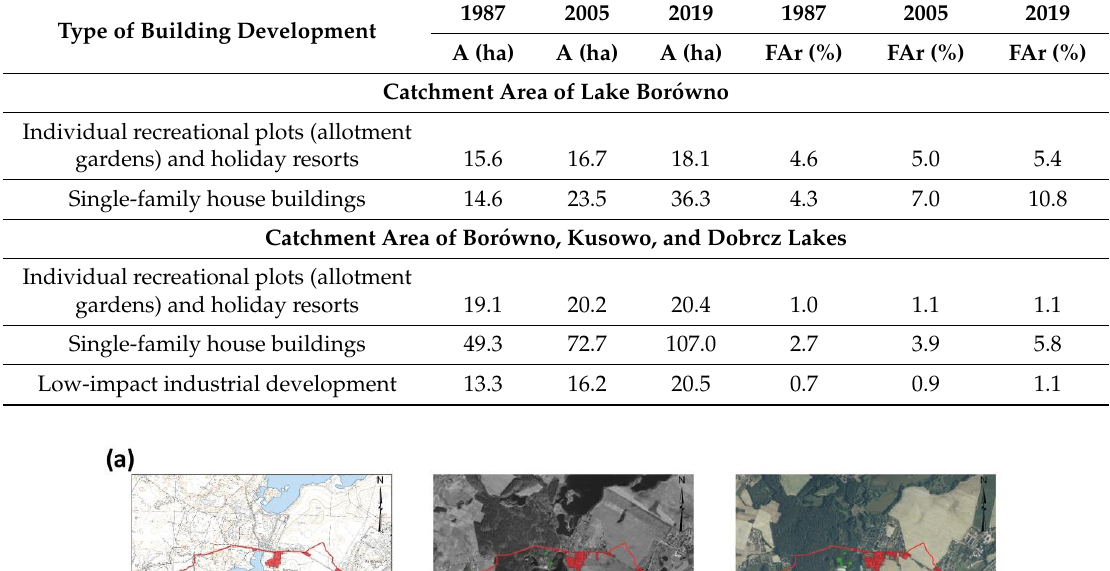
Table 3. Changes in the building development area [A] and floor area ratio [FAr] in the catchment of Lake Bor ó wno and the catchment of Lakes Bor ó wno, Kusowo, and Dobrcz (measured and calculation based on [63,68,69]).